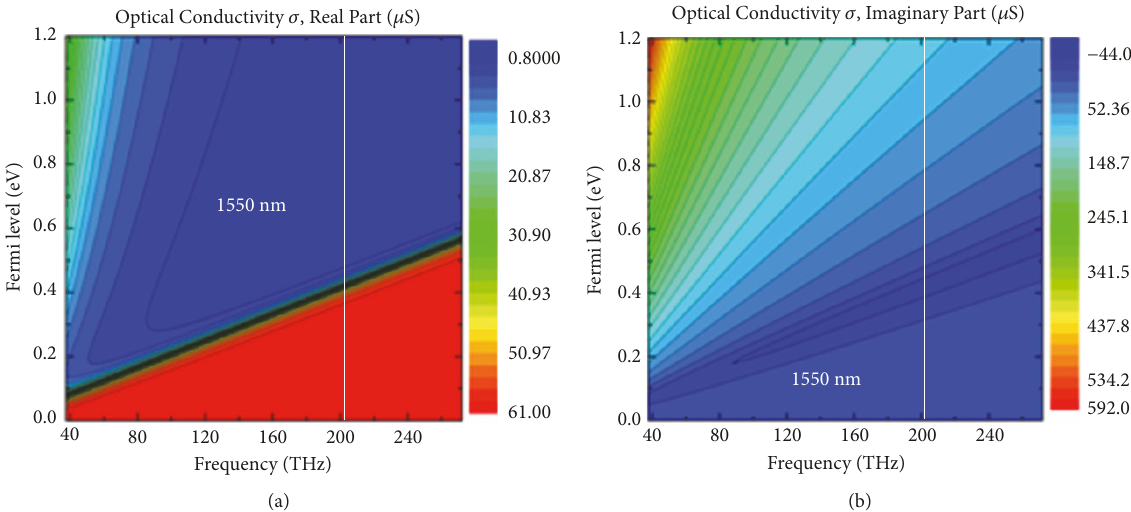
Figure 1: Calculated optical conductivity of graphene as a function of Fermi level. (a) The real part of the optical conductivity. (b) The imaginary part of the optical conductivity.